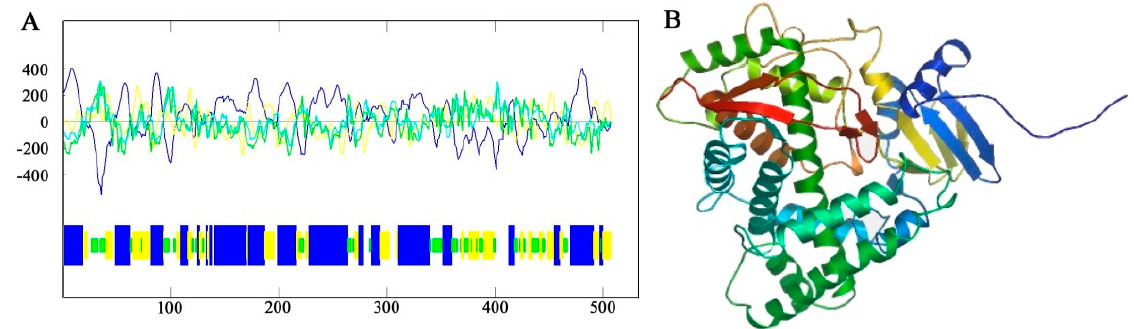
Figure 5. The prediction of secondary structure and tertiary structure of F3 ′ 5 ′ H from B. acuminata flowers. ( A ) Protein secondary structure prediction: Blue-Helix, Yellow-Sheet, Green-Turn, White-Coil. ( B ) Protein tertiary structure prediction.